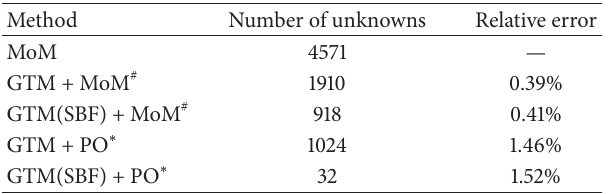
Table 1: Comparison of the computation results of the example in Figure